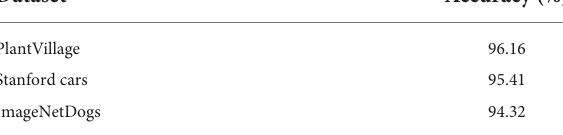
TABLE 13 Average classification accuracy of DS-MENet on public